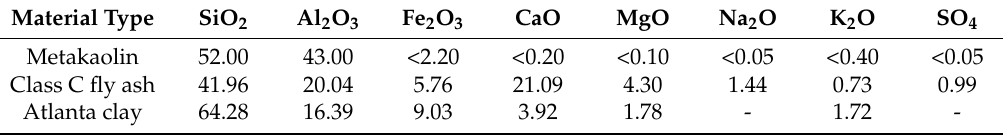
Table 1. Chemical composition of metakaolin, class C fly ash, and Atlanta clay. All values are in wt %. Material